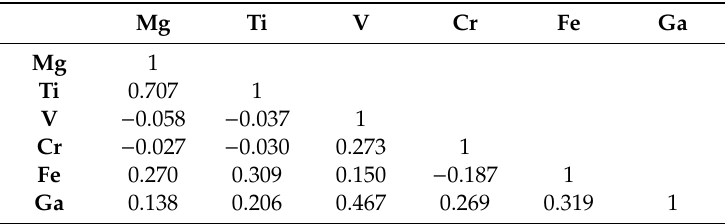
Table 9. Correlation table for trace elements of only blue / green and pink sapphires from the secondary Montana sapphire